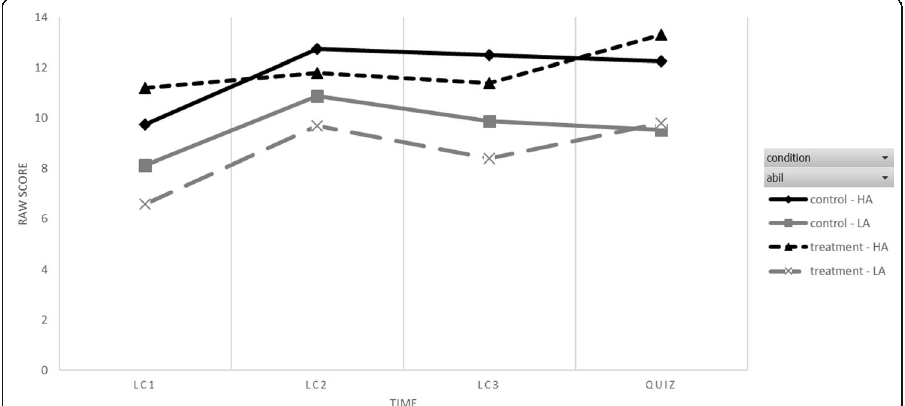
Fig. 3 Plot of mean raw score for mathematics students ’ performance over time